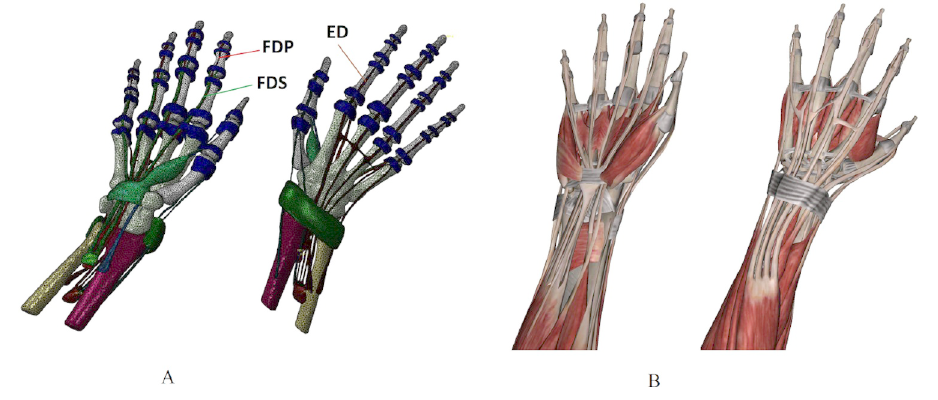
Fig 1. FE-DHHM and human hand anatomy. (A) FE-DHHM. (B) human hand anatomy.